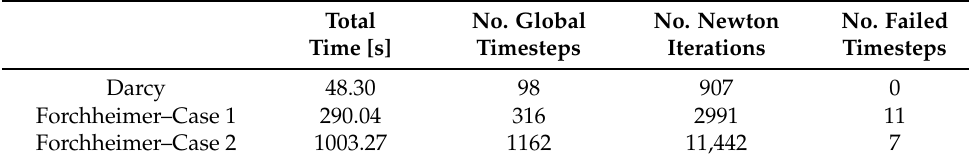
Table 6. Computational effort and numerical behavior for Scenario (c).